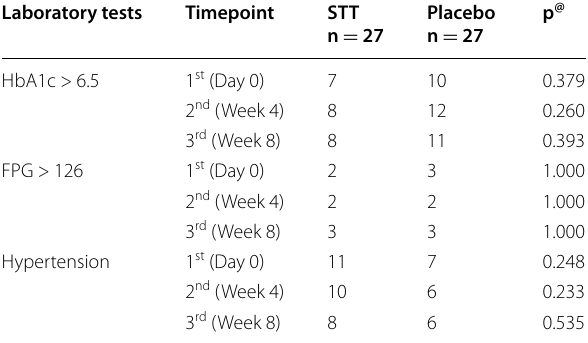
Table 2 Medical health during the period of treatment (8